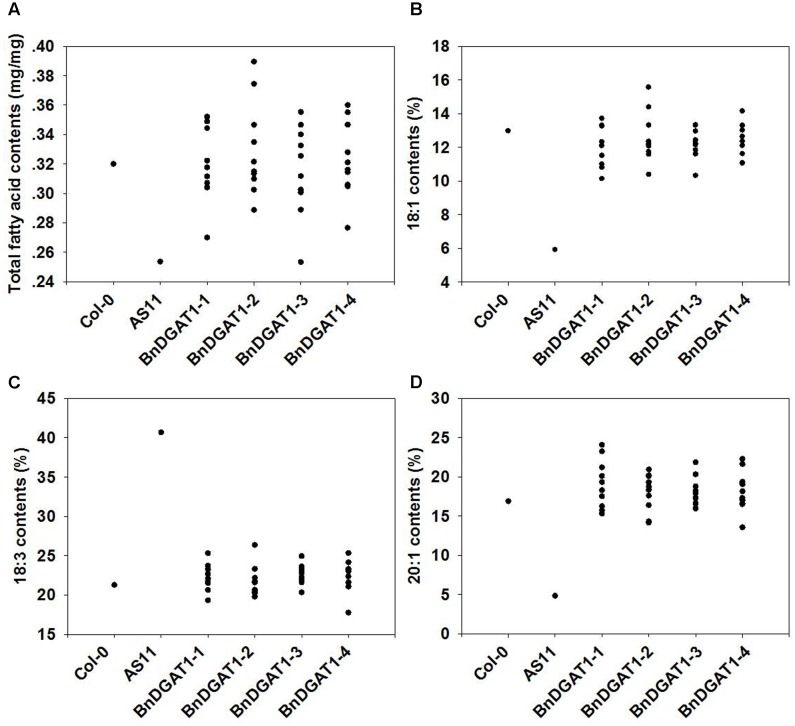
Seed oil contents and fatty acid profiles of BnDGAT1 transgenic lines, AS11 and wild type Arabidopsis. Seed oil contents (A), relative contents of 18:1 (B), relative contents of 18:3 (C), and relative contents of 20:1 (D). Ten independent lines were analyzed for each BnDGAT1 construct. Three biological replicates were analyzed for each line and dots represent their average values.